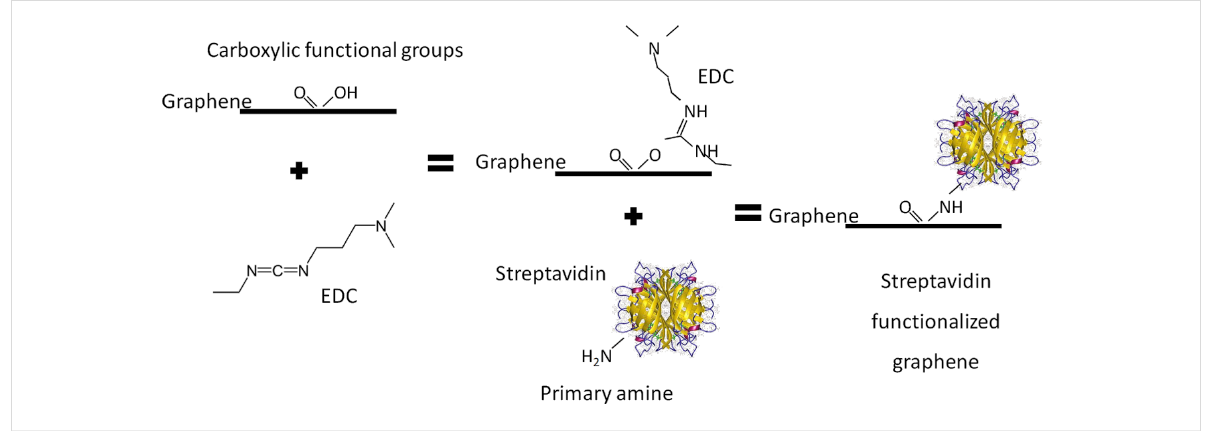
Figure 5: Schematic representation of the EDC covalent functionalization of graphene with streptavidin.